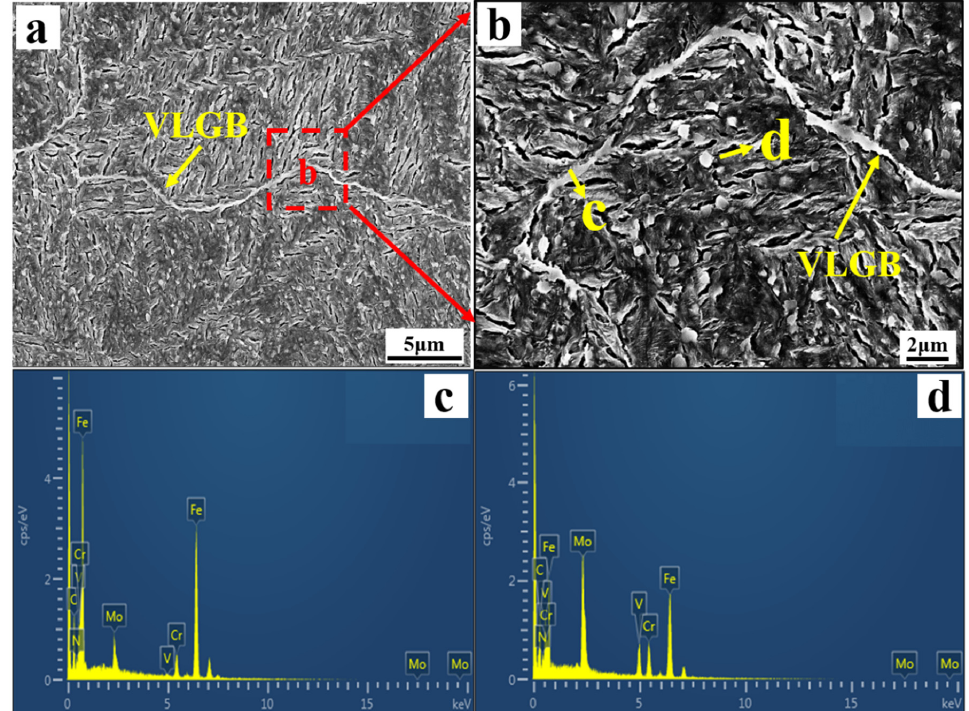
Figure 7. ( a ) Vein-like precipitates in the di ff usion layer after compound percolation; ( b ) local en- largement corresponding to the red box in ( a ); ( c , d ) EDS corresponding to the vein-like precipitates and granular precipitates in ( b